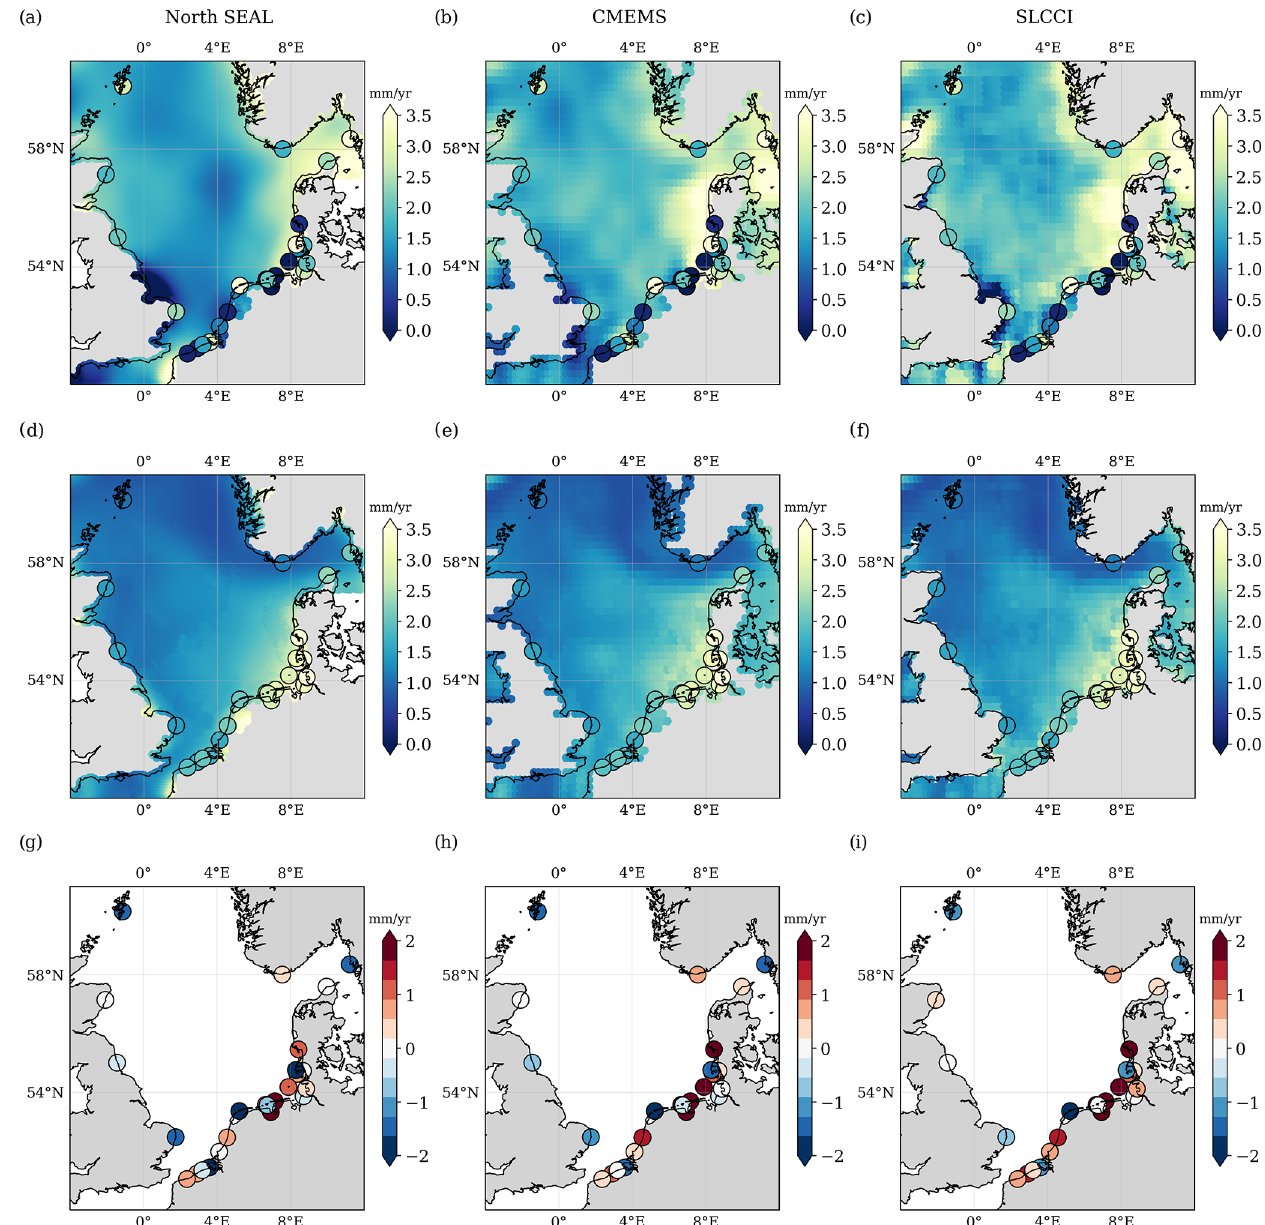
Figure 8. Absolute sea level trends over the period 1995–2015 (a–c) and associated uncertainties (d–f) for the three altimetry datasets (North SEAL, CMEMS, SL_cci) and TG measurements corrected for VLM. Differences in absolute sea level trends in TG locations (g–i) . None of these differences are statistically